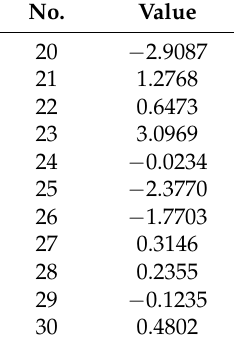
Table 4. Results of model verification for different prediction models.